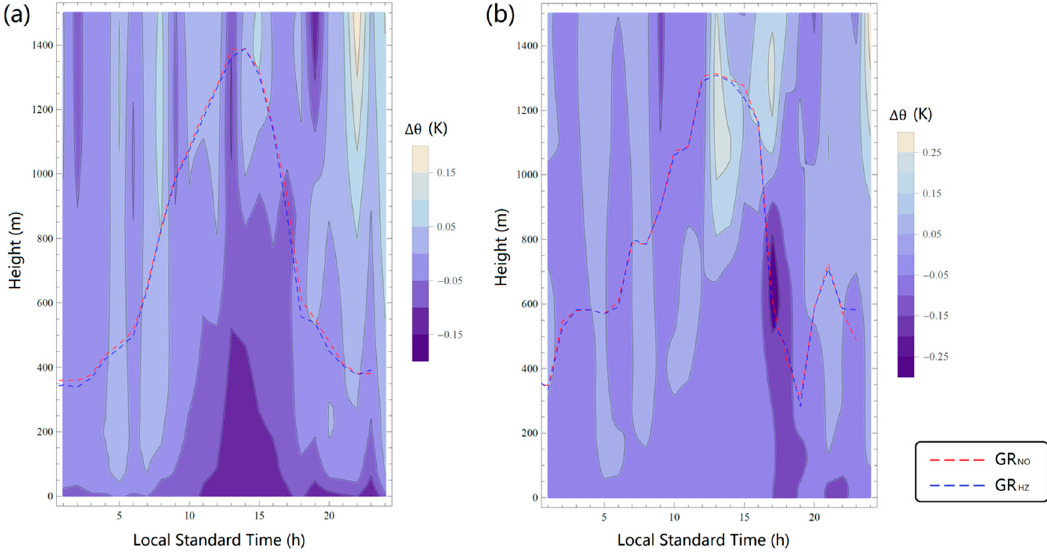
Figure 12. The same as Figure 7, but for GR NO and GR HZ (all green roofs in Hangzhou urban grids) scenarios, in ( a ) Hangzhou and ( b ) Haining (see Figure 1b).